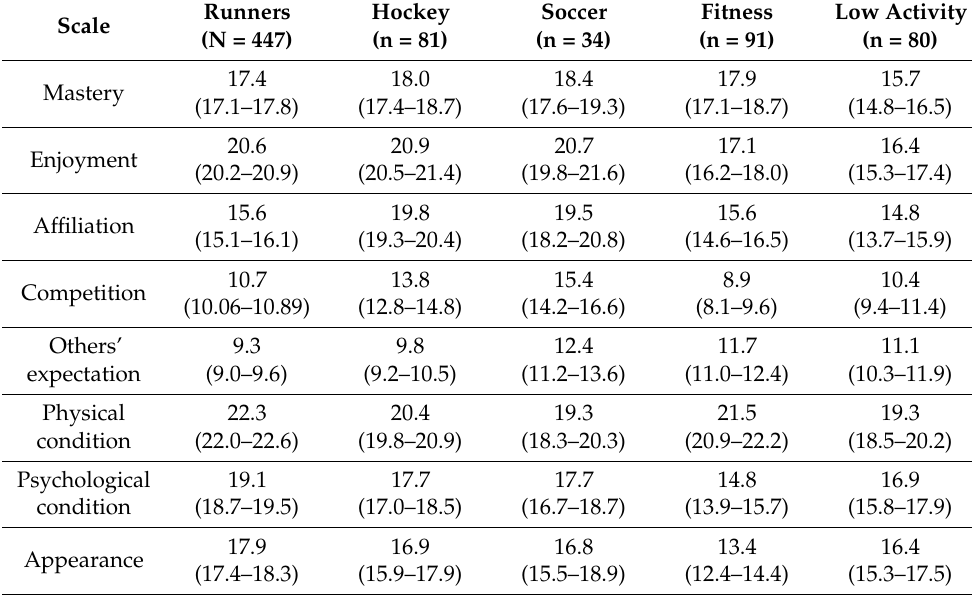
Table 5. Average scores (95% CI) for each group of participants on the eight PALMS-D